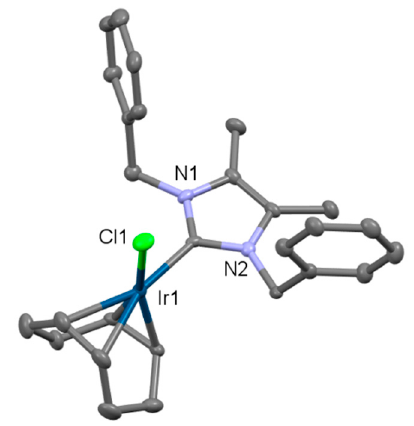
Scheme 3. Preparation of iridium complex 12 .